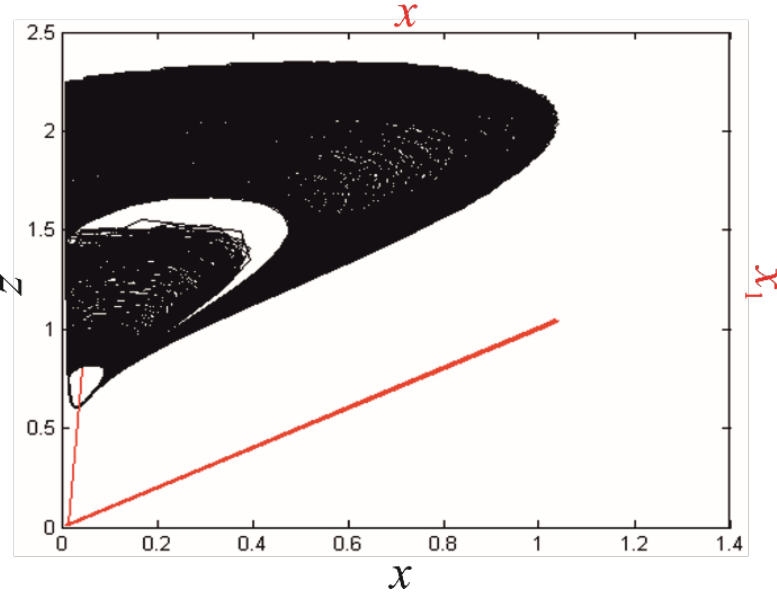
Figure 14. Master ( x , z )—black color, and master–slave ( x , x 1 )—red color phase portraits. Figure 17a,b show that the values of controllers became constants in time further proof that synchronization is